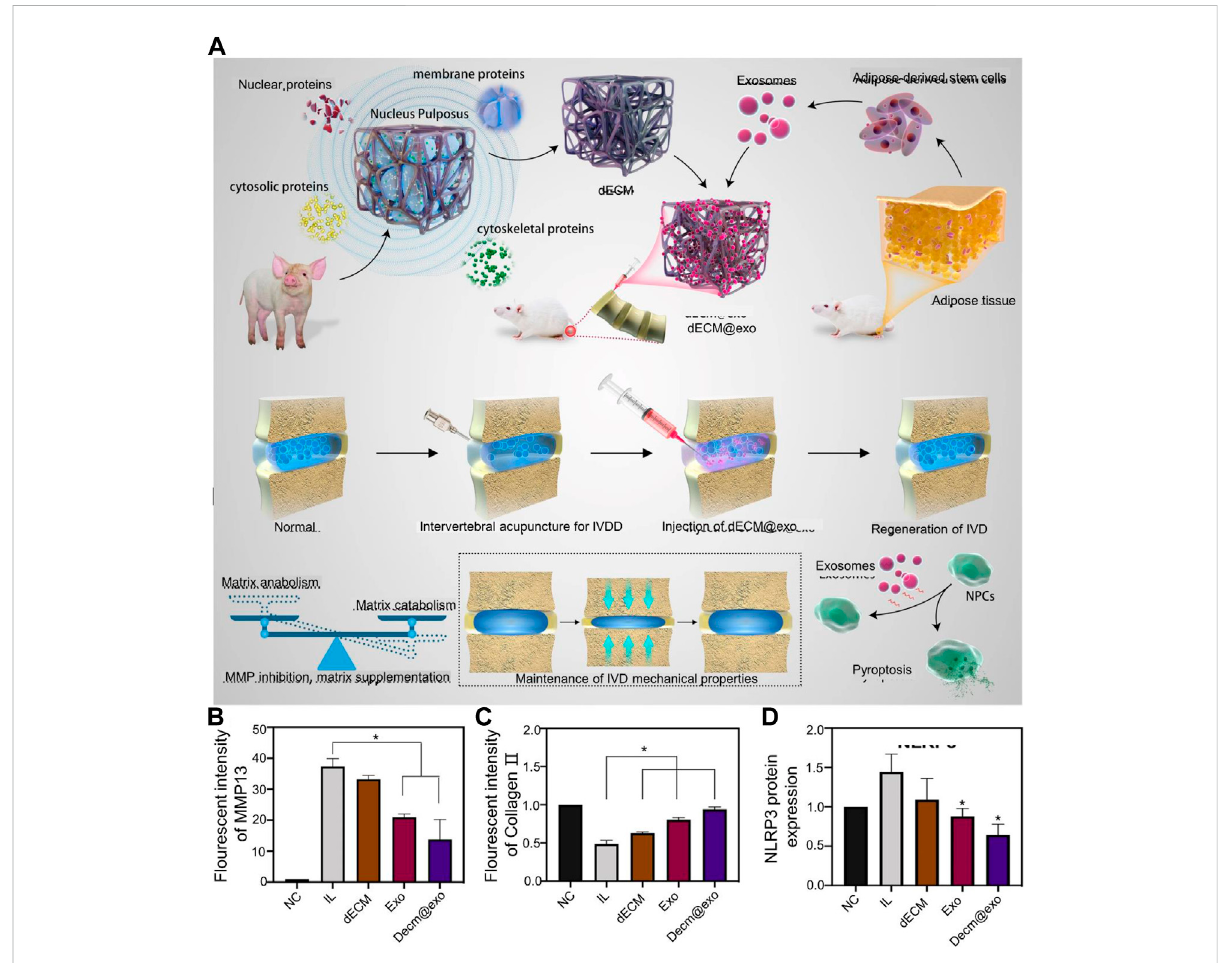
FIGURE 2 (A) Schematic diagram of the preparation mechanism of dECM@exo. (B) Quantitative analysis of the fl uorescence intensity of matrix metallopeptidase13 (MMP-13). (C) Quantitative analysis ofthe fl uorescence intensity of collagen 11in each group. (D) Quanti fi cation of NOD-, LRR- and pyrin domain-containing protein 3 (NLRP3) expression. Reproduced with permission from (Xing et al.,